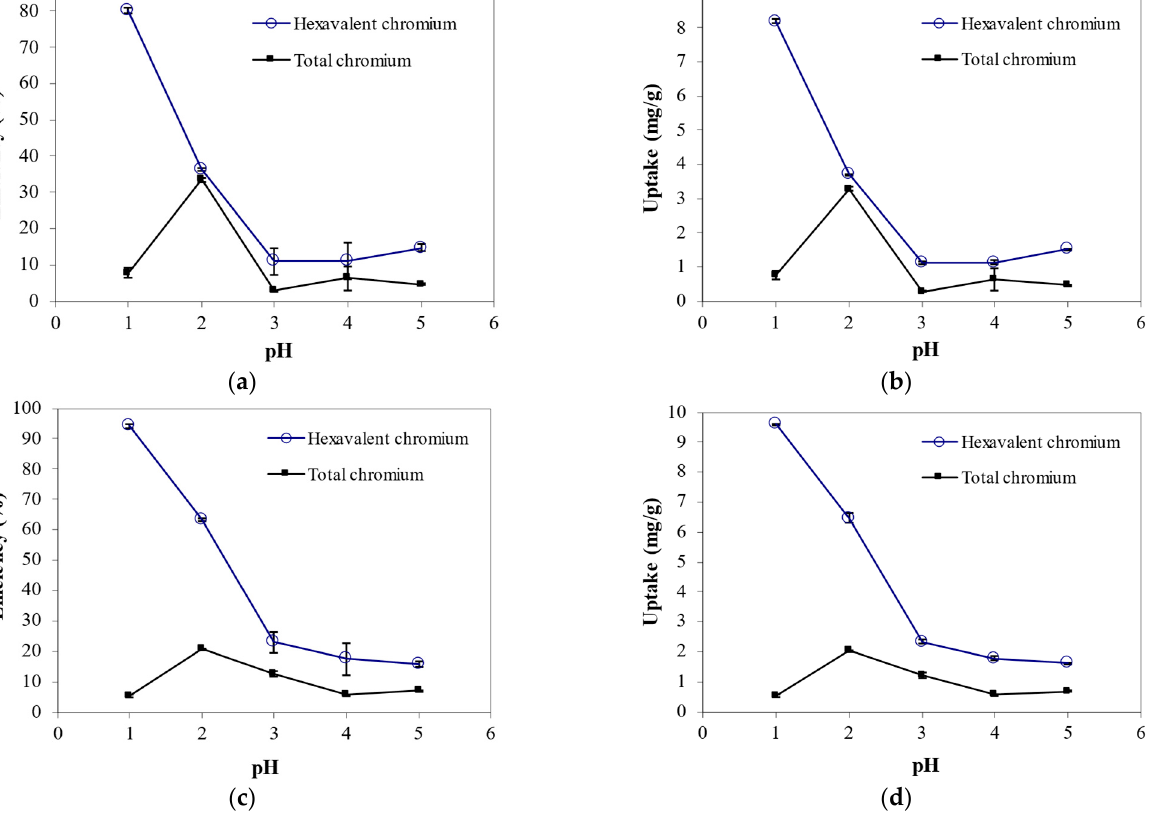
Figure 1. Effect of the initial solution pH on ( a ) process efficiency and ( b ) chromium uptake by Bacillus megaterium inactive biomass and on ( c ) process efficiency and ( d ) chromium uptake by Rhodotorula sp. inactive biomass (biosorbent dose = 5 g/L, contact time = 48 h, temperature = 25 °C, initial concentration = 51.04 mg/L).